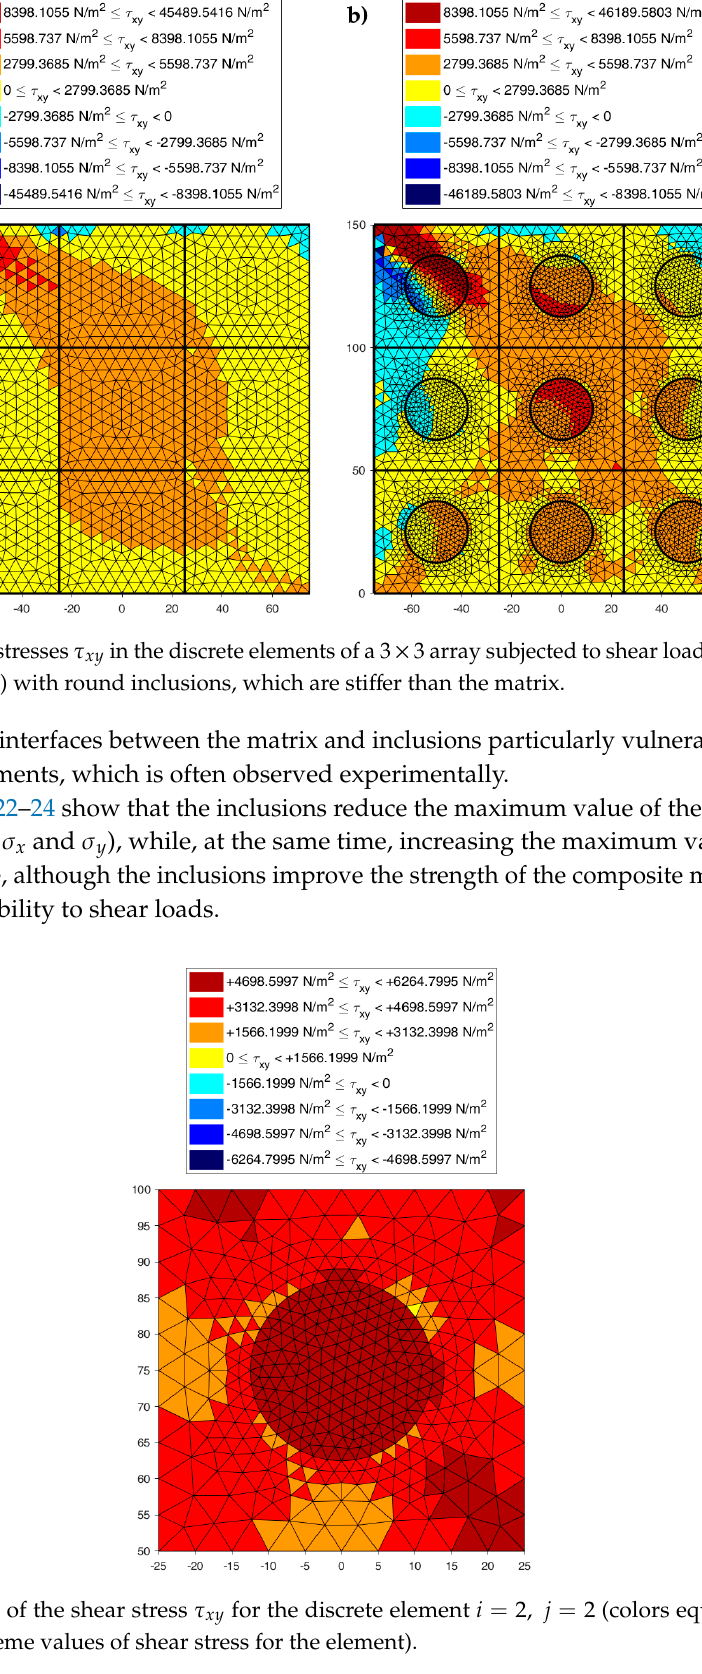
between the extreme values of shear stress for the element).